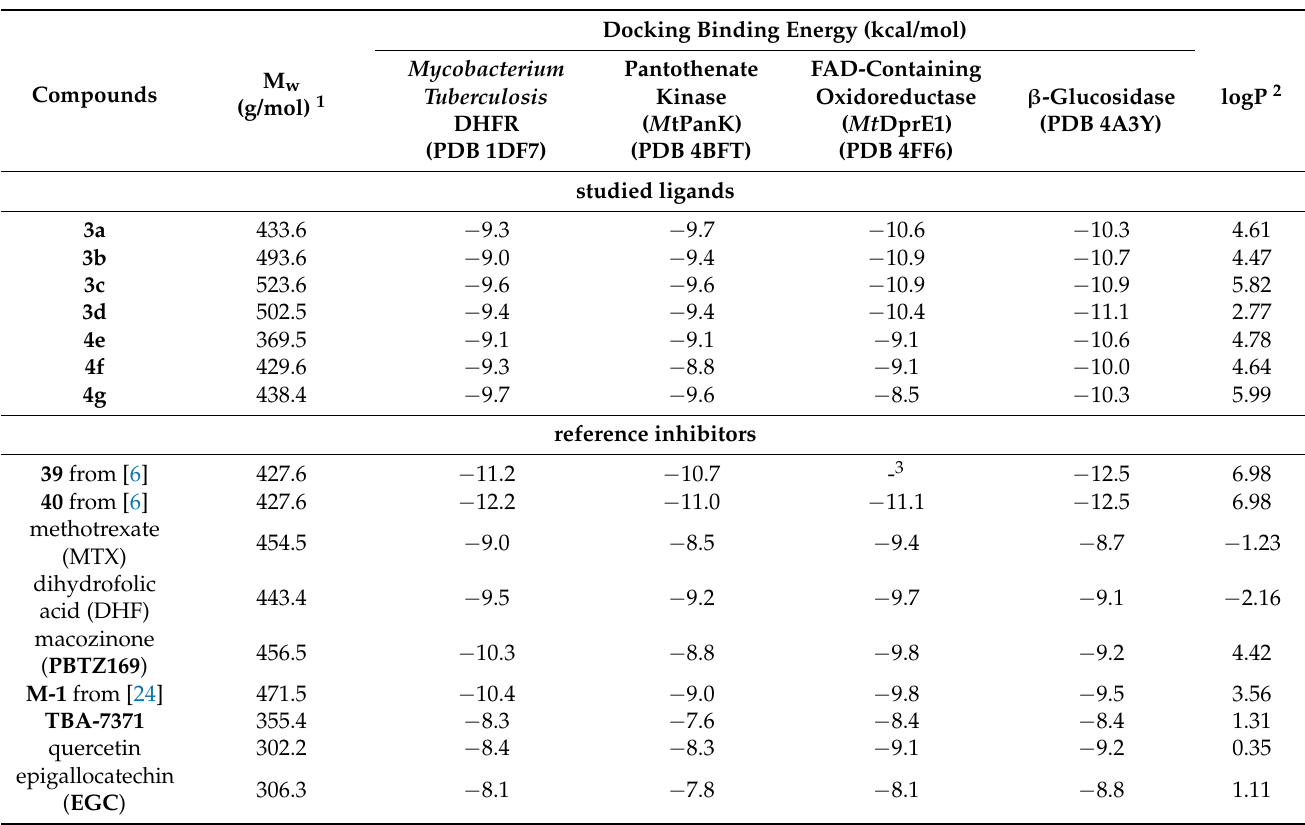
Table 2. Molecular docking binding score for 3a-d , 4e-g, and some existing inhibitors toward the key enzymes of Mycobacterium tuberculosis and β